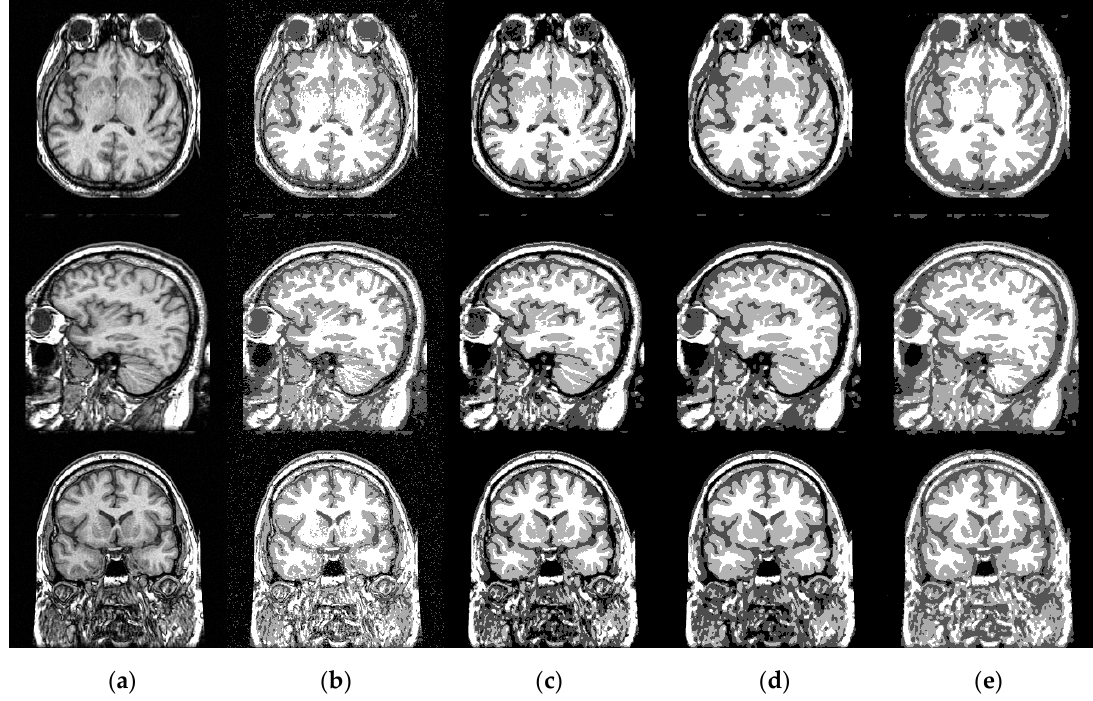
Figure 3. The segmentation results of RC_LCI compared with MICO, BCFCM, and FLICM on real images: ( a ) original real brain MRI; ( b ) segmentation results of MICO; ( c ) segmentation results of BCFCM; ( d ) segmentation results of FLICM; and ( e ) segmentation results of RC_LCI.